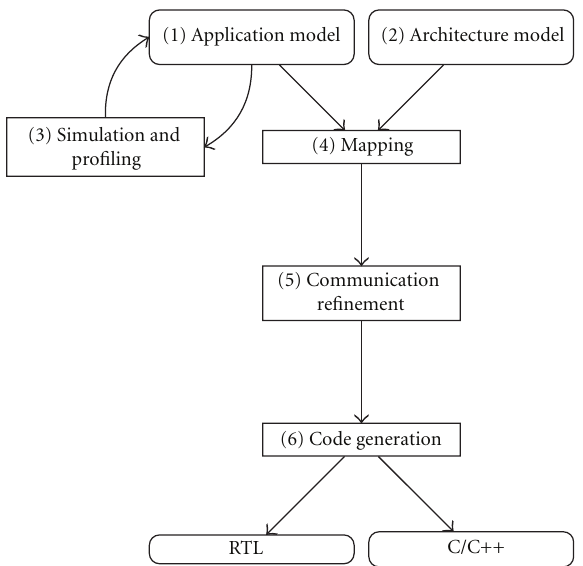
Figure 1: Overview of the design flow.